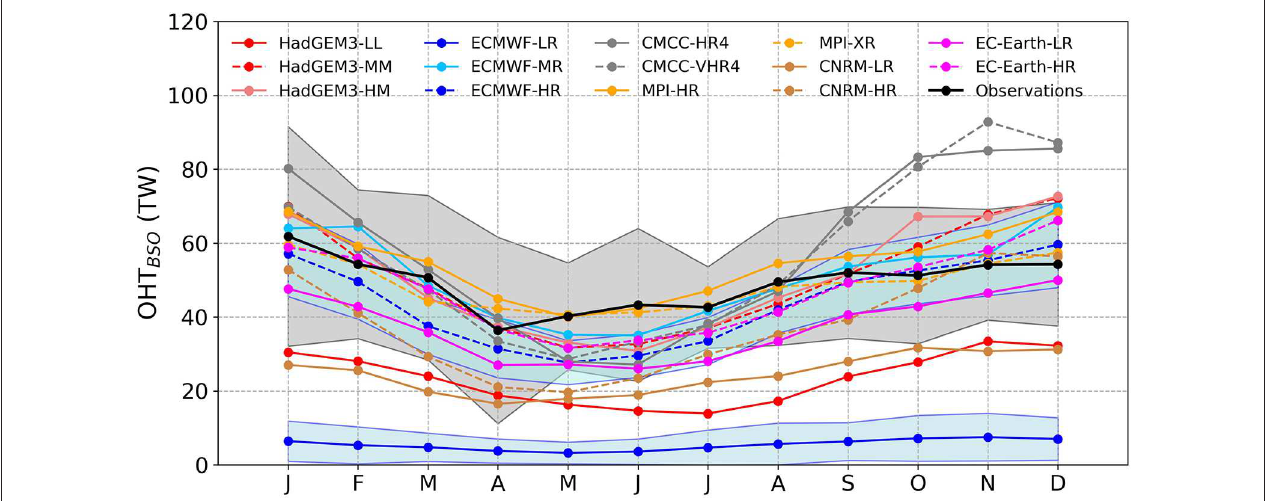
FIGURE 4 | Seasonal cycle of ocean heat transport (OHT) at the Barents Sea Opening (BSO, reduced transect, 20 ◦ E, 71.5–73.5 ◦ N) averaged over 1998–2014 using HighResMIP hist-1950 model outputs and IMR observations. The blue shadings of ECMWF-LR and ECMWF-HR represent the ensemble standard deviation (six members for each). The gray shading of observations represents the temporal standard